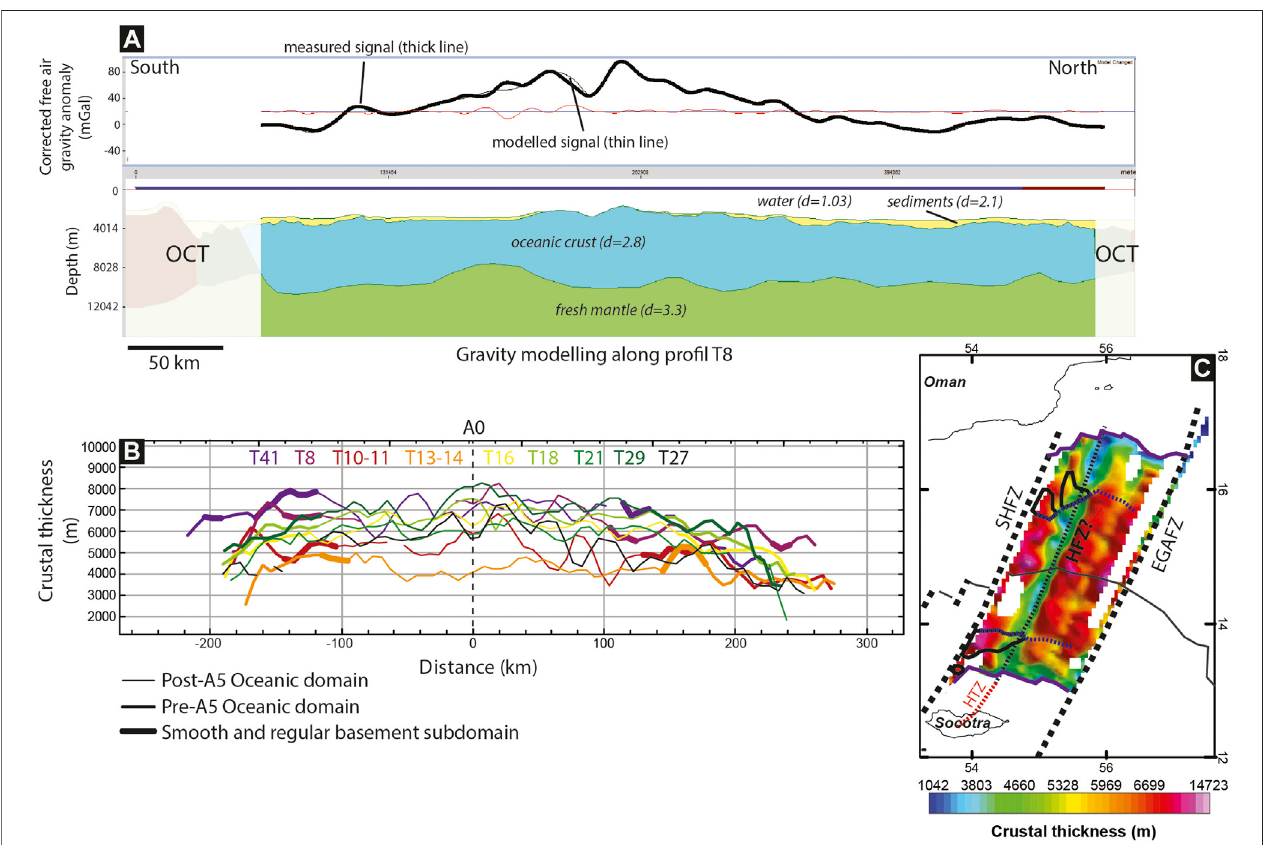
FIGURE 5 | (A) Example of gravity modelling along transect T8. Thick black line represents the measured gravity signal, thin black line represents the modelled gravity signal. The error near the ridge axis is certainly linked to the data gap in the seismic acquisition in this area. (B) Compilation of the different pro fi les of crustal thickness computed for the seismic transects. (C) Computed crustal thickness map. HFZ, Hadibo Fracture Zone.